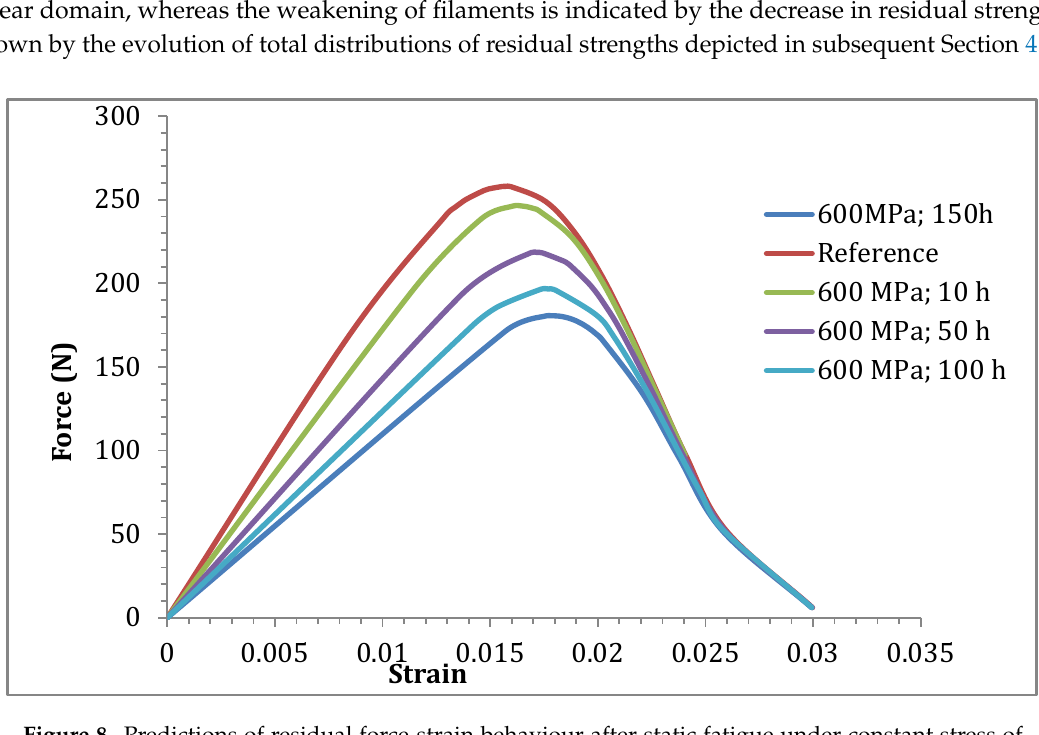
Table 2. Main characteristics of residual tensile behaviour after static fatigue (test#4 in [15]).